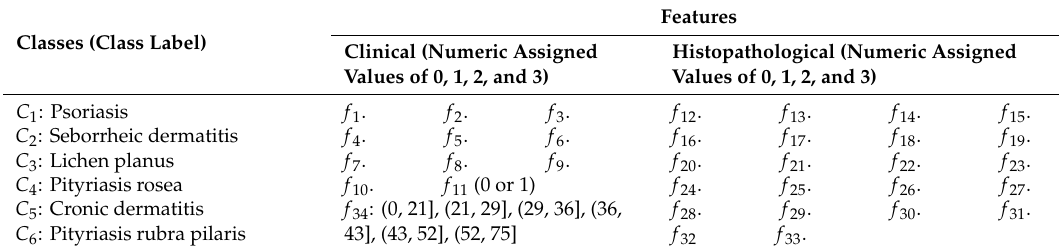
Table 2. The dermatology dataset used in the experiments